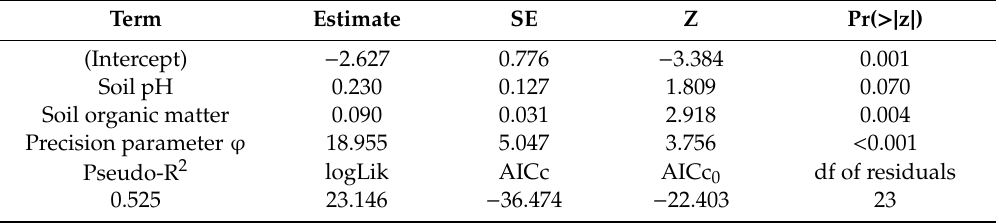
Abbreviations: SE – standard error, Z – empirical test statistic, Pr( >| z | ) – p-value, based on comparison of empiric and tabular Z, logLik – log-likelihood, AIC c – model’s Akaike’s Information Criterion corrected for small